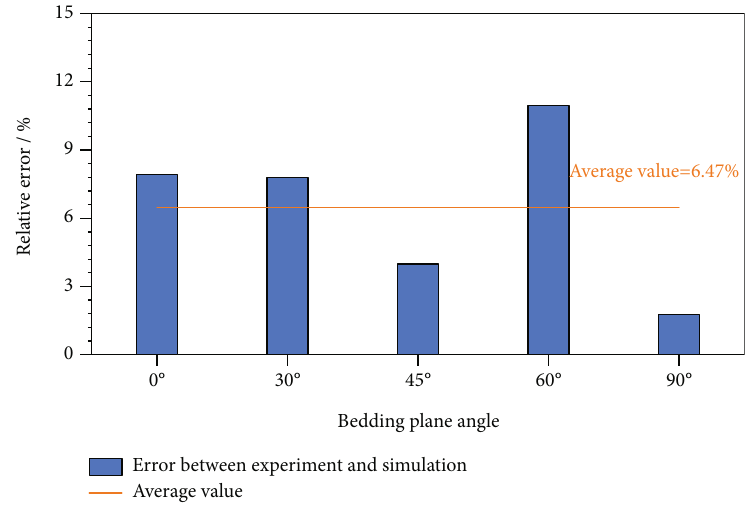
Figure 9: Relative error between uniaxial test and its simulation.